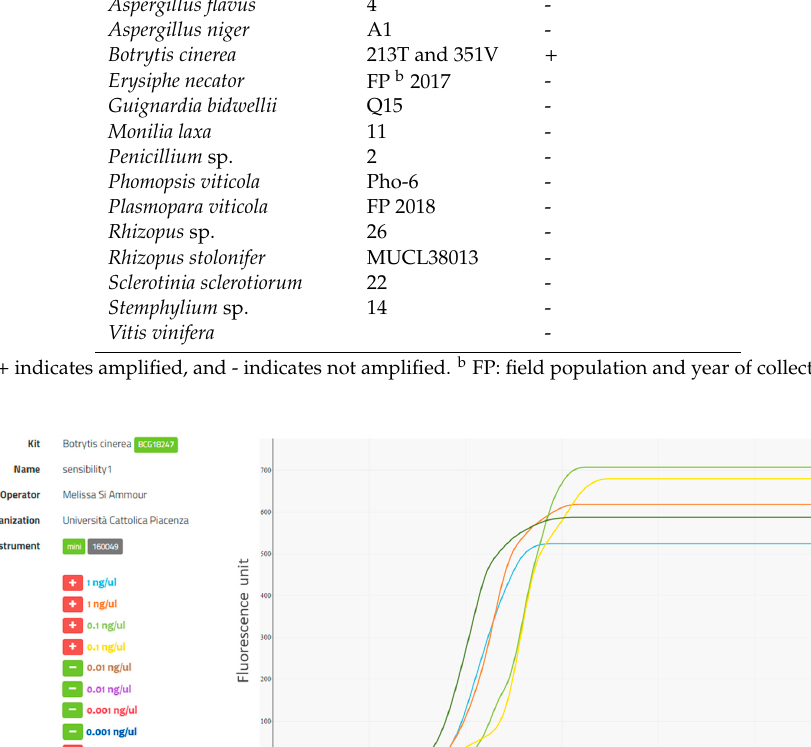
Table 1. List of isolates used for specificity tests of the real-time loop-mediated isothermal amplification (LAMP) assay.